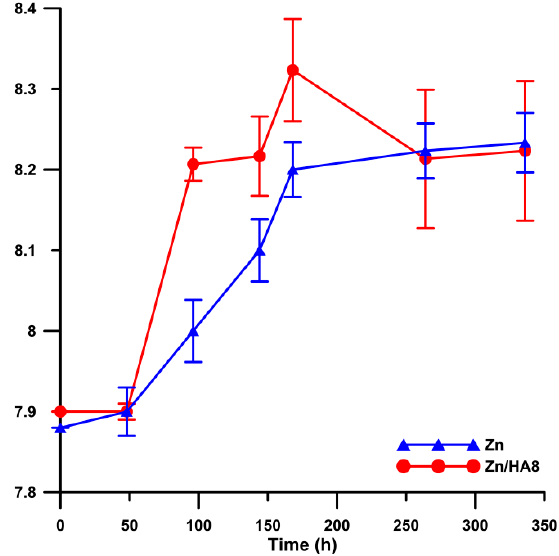
Figure 9. Development of pH during the immersion tests.